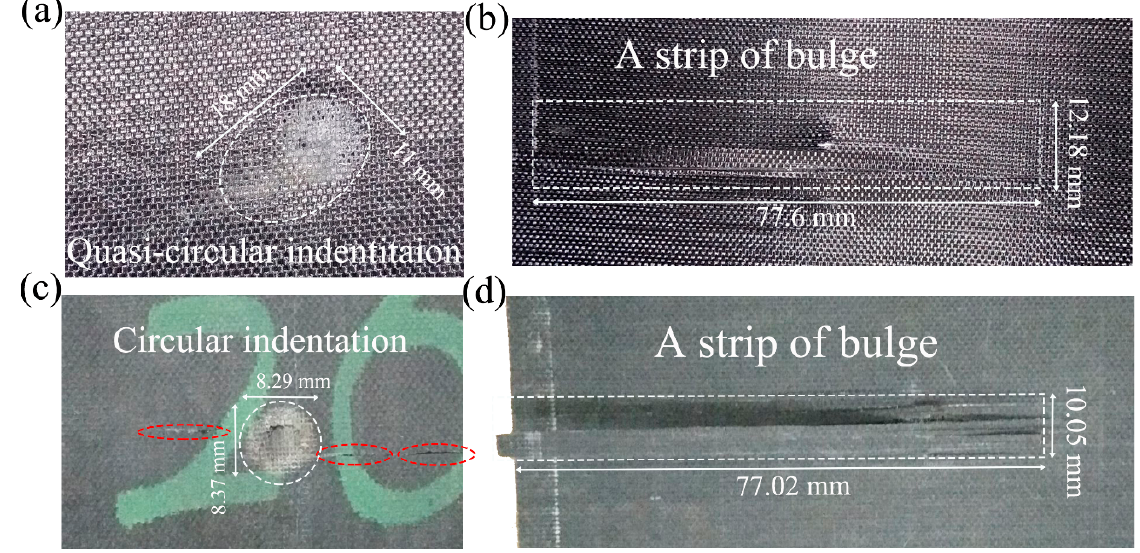
Figure 6. Photos of ( a ) the front and ( b ) back faces of a dry specimen, ( c ) the front and ( d ) back faces of a saturated specimen under an impact velocity of 45 m/s with the sphere-ended projectile.